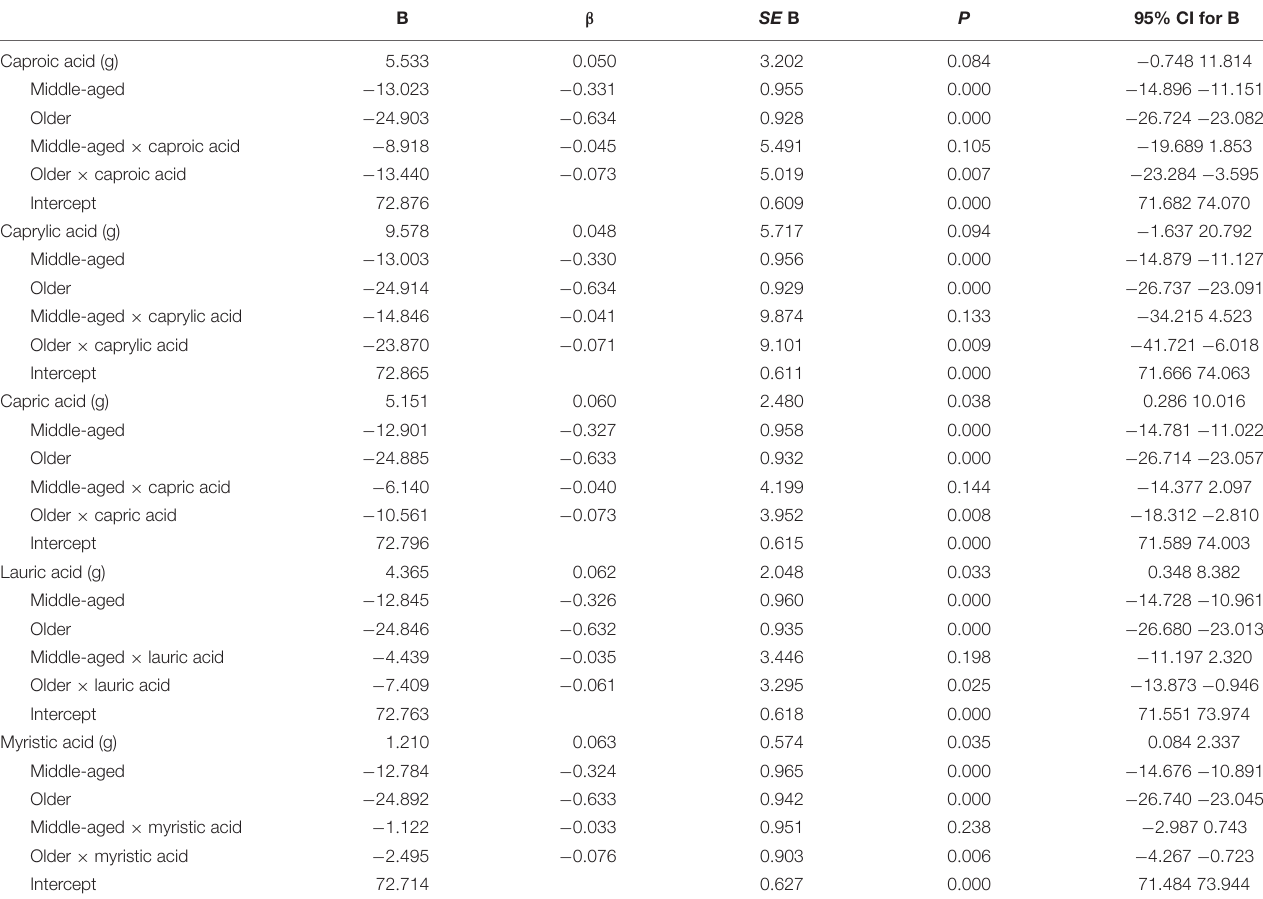
TABLE 8 | Moderator analyses